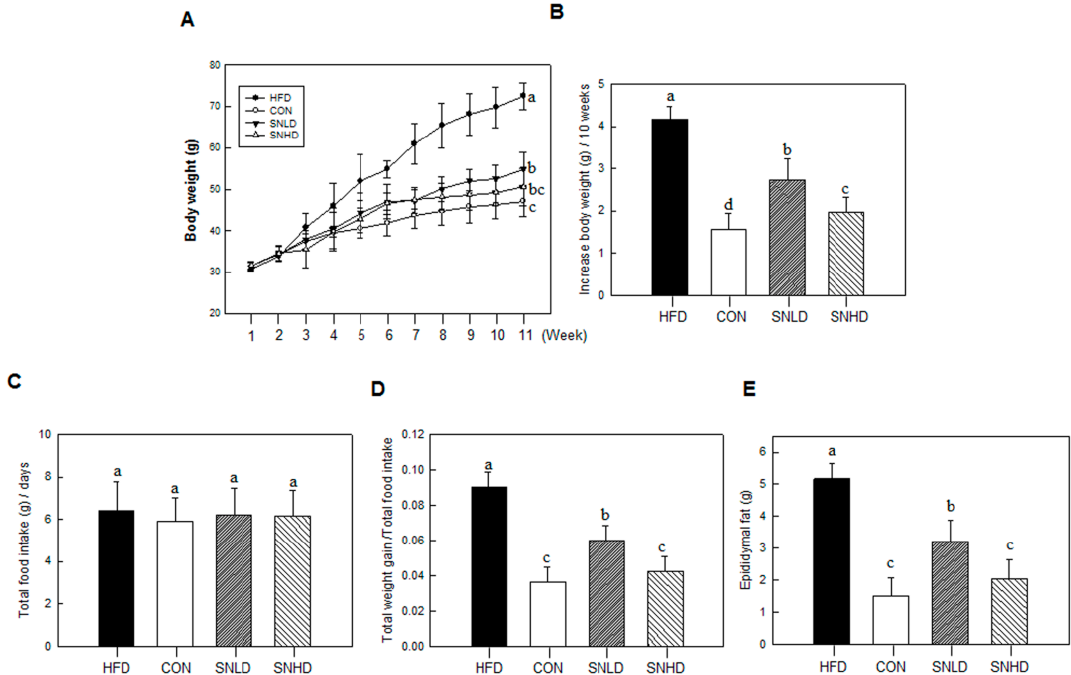
Figure 9. Effects of SN on physical changes in high-fat-diet-induced obese mouse model. ( A ) Growth curve; ( B ) Body weight gain; ( C ) Total food intake; ( D ) Body weight gain normalized by food intake; ( E ) Epidymal fat. CON: normal diet, HFD: high fat diet, SN: seapolynol, SNLD: seapolynol low dose, SNHD: seapolynol high dose. Data are presented as means ± SD of eight mice. Means not designated by a common superscript are significantly different ( p < 0.05).